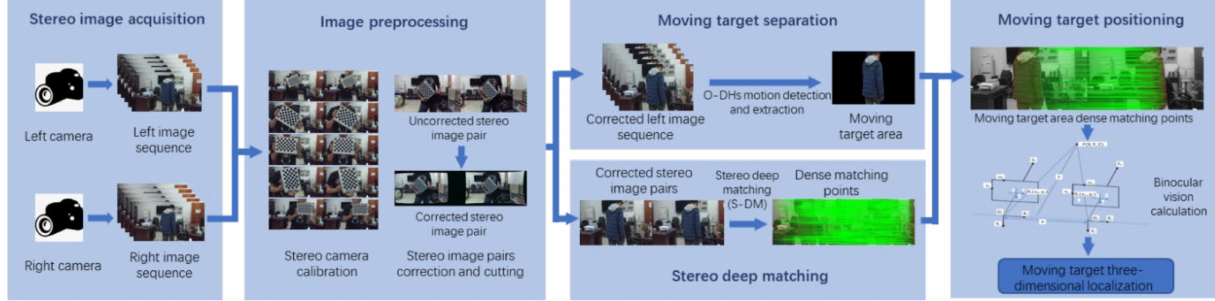
Figure 1. Moving target recognition and localization method framework. O-DHS—Otsu Delaunay Horn–Schunck method.